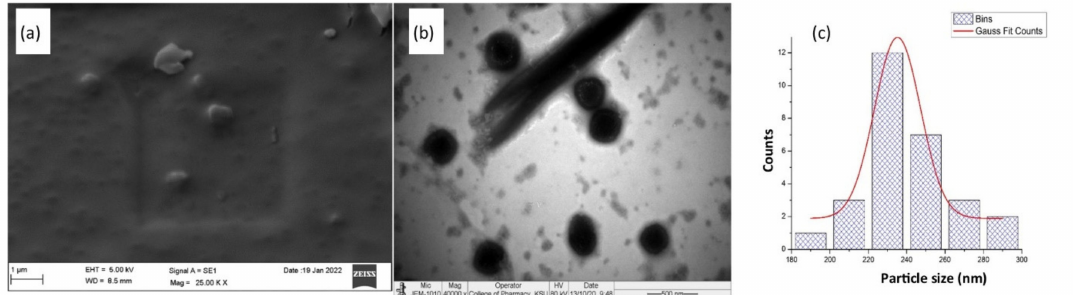
Figure 5. Morphological studies of LPHyNPs ( a ) SEM image, ( b ) TEM image, ( c ) size histogram of